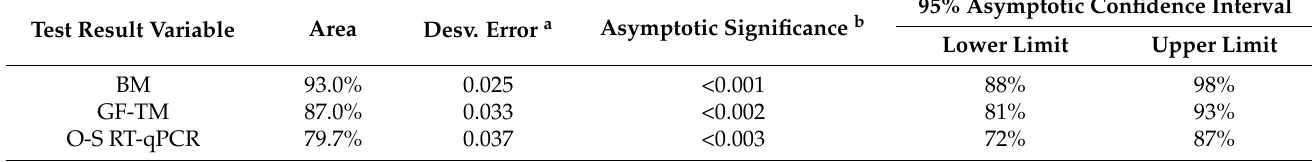
Table 3. Comparative ROC curve analysis between the RT-qPCR assays for the detection of the SARS-CoV2